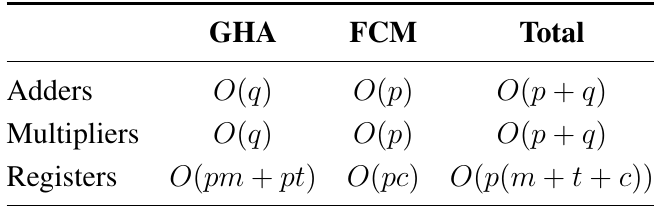
Table 5. Area complexities of the proposed spike sorting circuit.